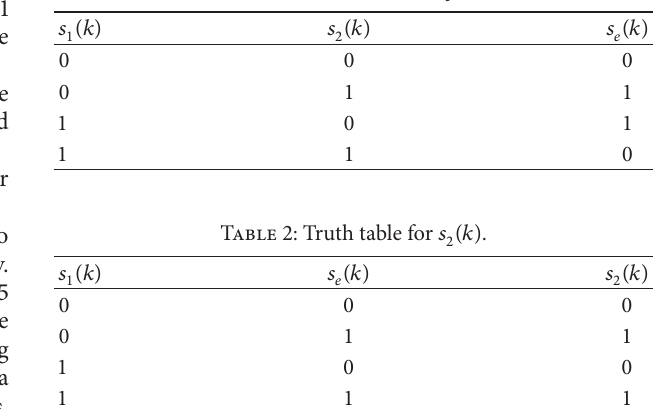
Table 1: Truth table for 𝑠 𝑒 (𝑘) .